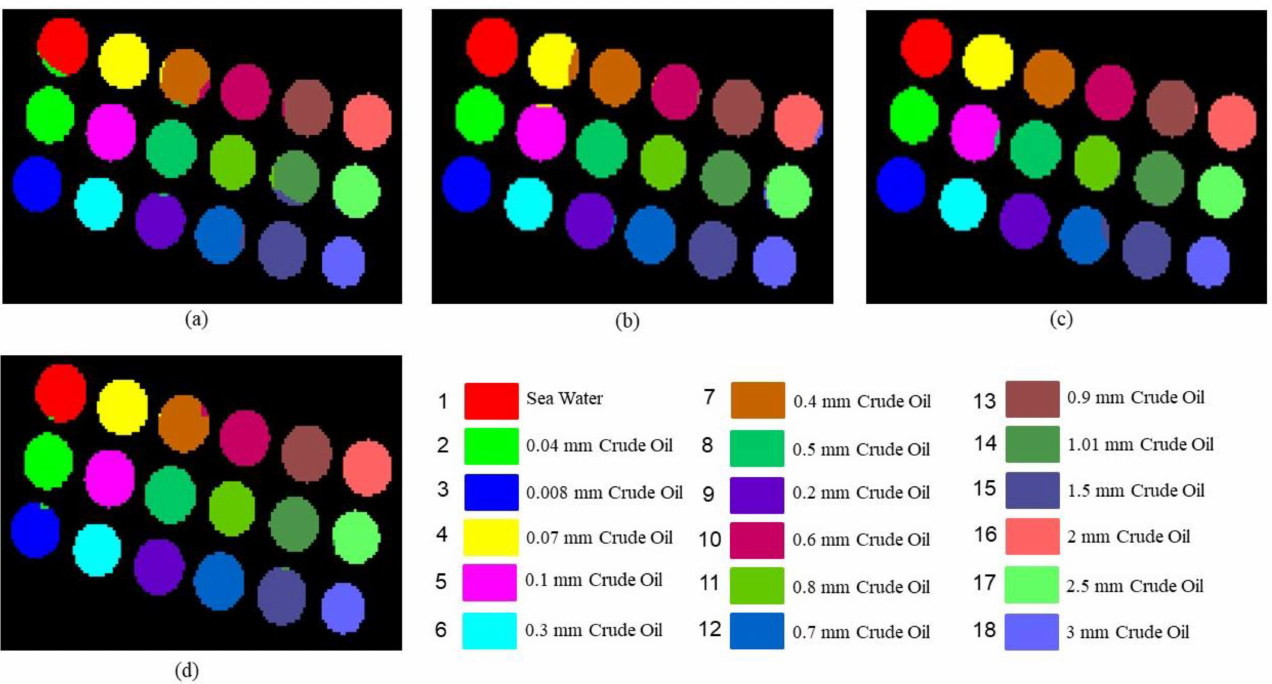
Figure 5. Detection results of the oil film thickness data. ( a ) CGCNN, ( b ) SSRN, ( c ) A2S2KResNet, ( d ) GCAT.